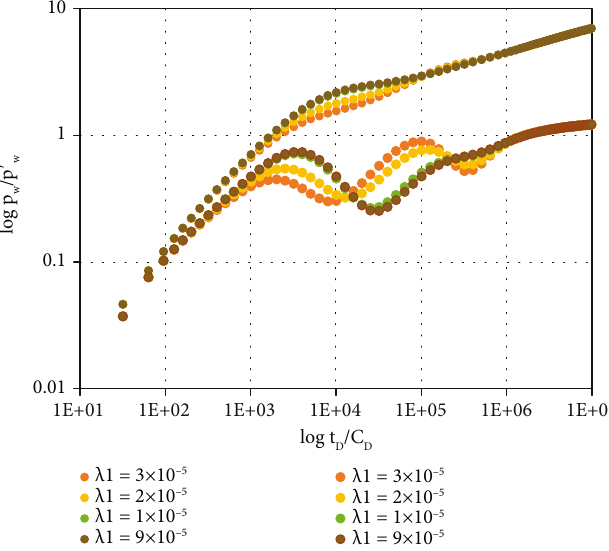
Figure 9: The in fl uence of channeling coe ffi cient of the inner zone on pressure di ff erence and pressure di ff erence derivative